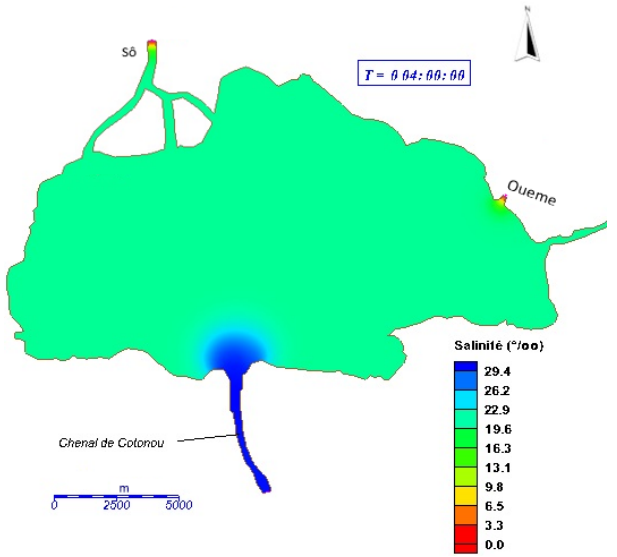
Figure 2. Spatio-temporal variation of salinity-fresh water during the low-flow period at the start of the simulation.